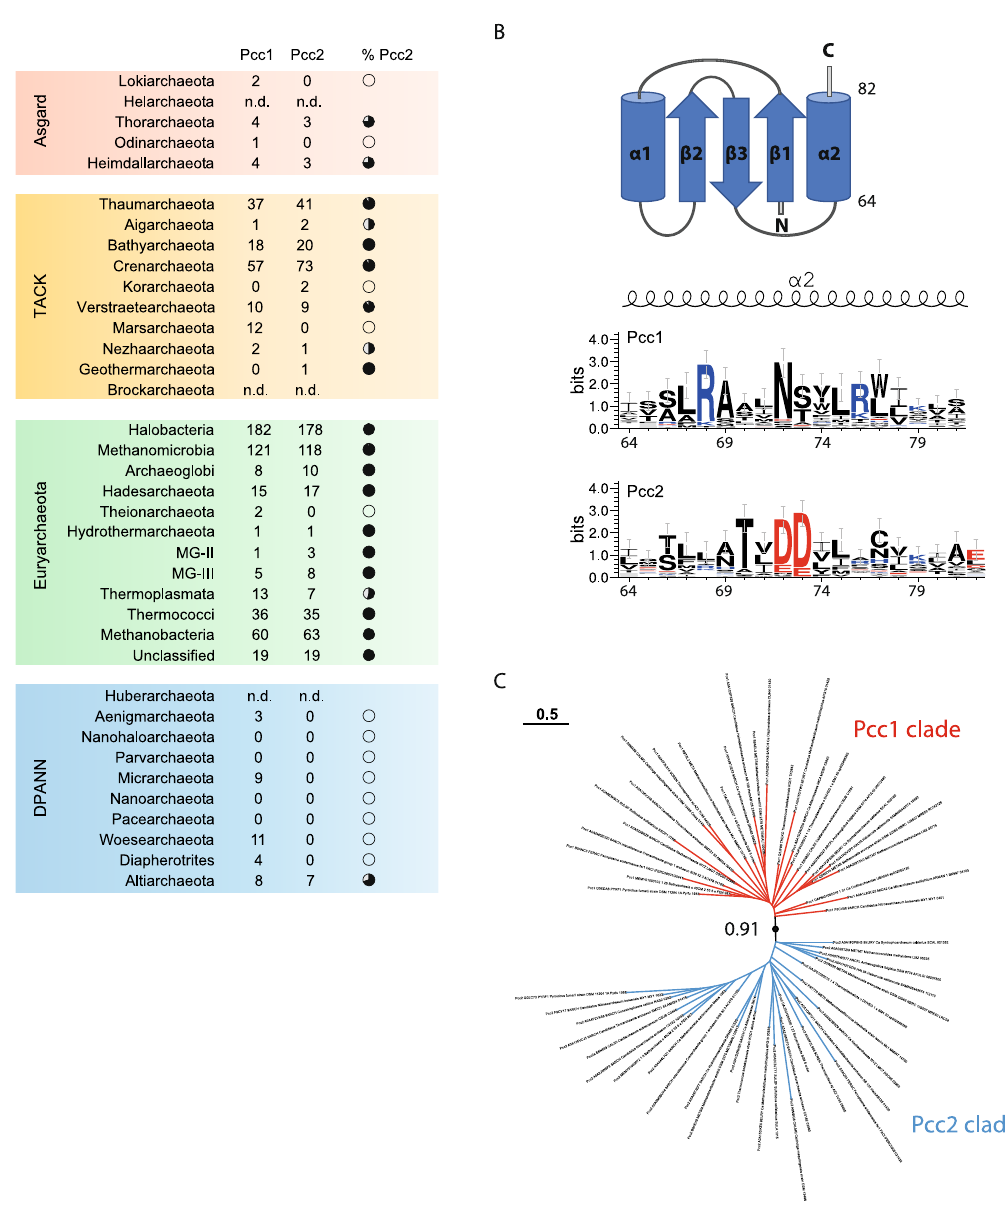
clades.Maximumlikelihoodphylogenetictreewasinferredfromanalignmentof27 Pcc1 or Pcc2 sequences representative of the archaeal diversity. The